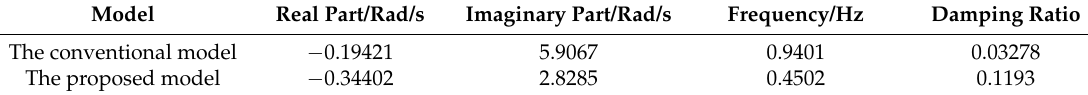
Table 2. Objective mode tuned by different models.